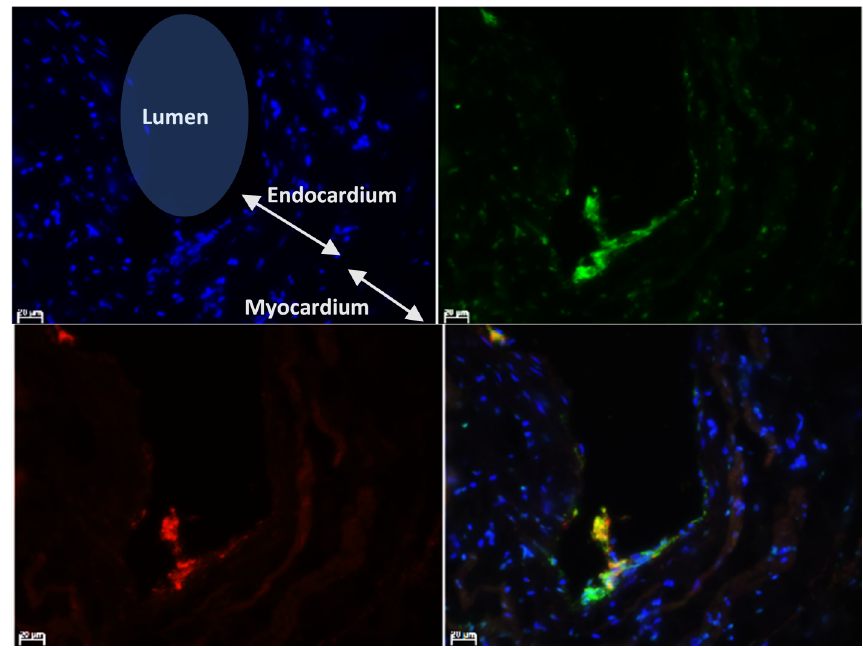
Figure 3. Double immunostaining for vWF and integrin αIIb. In addition to vWF, each slide was also stained for Integrin αIIb, a platelet marker, so the quantification of endocardial vWF would not include any platelets which are known to also express vWF. Images were displayed as split channels with the merged image on the bottom right. 400× magnification; bar = 20 µm; Blue—Nuclei; Green—vWF; Red—Integrin αIIb (CD41) .